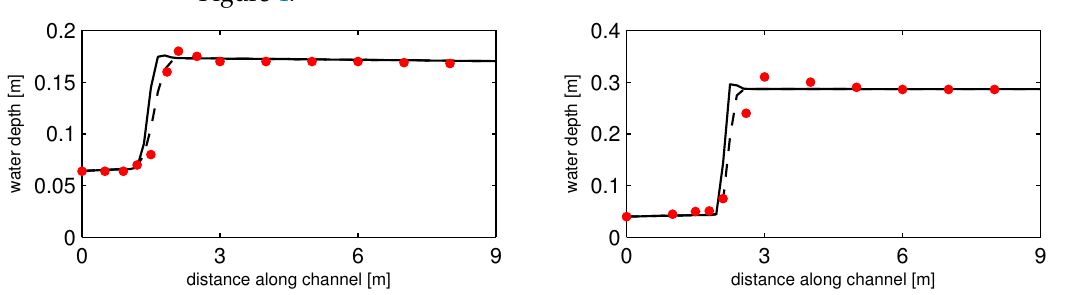
Figure 4. Computed and recorded jump profiles for F u = 2.30 ( left panel ) and F u = 5.74 ( right panel ). Black solid line: present method using Fromm’s scheme; black dash line: present method using first order upwind scheme; red dots: experimental data of Gharangik and Chaudhry